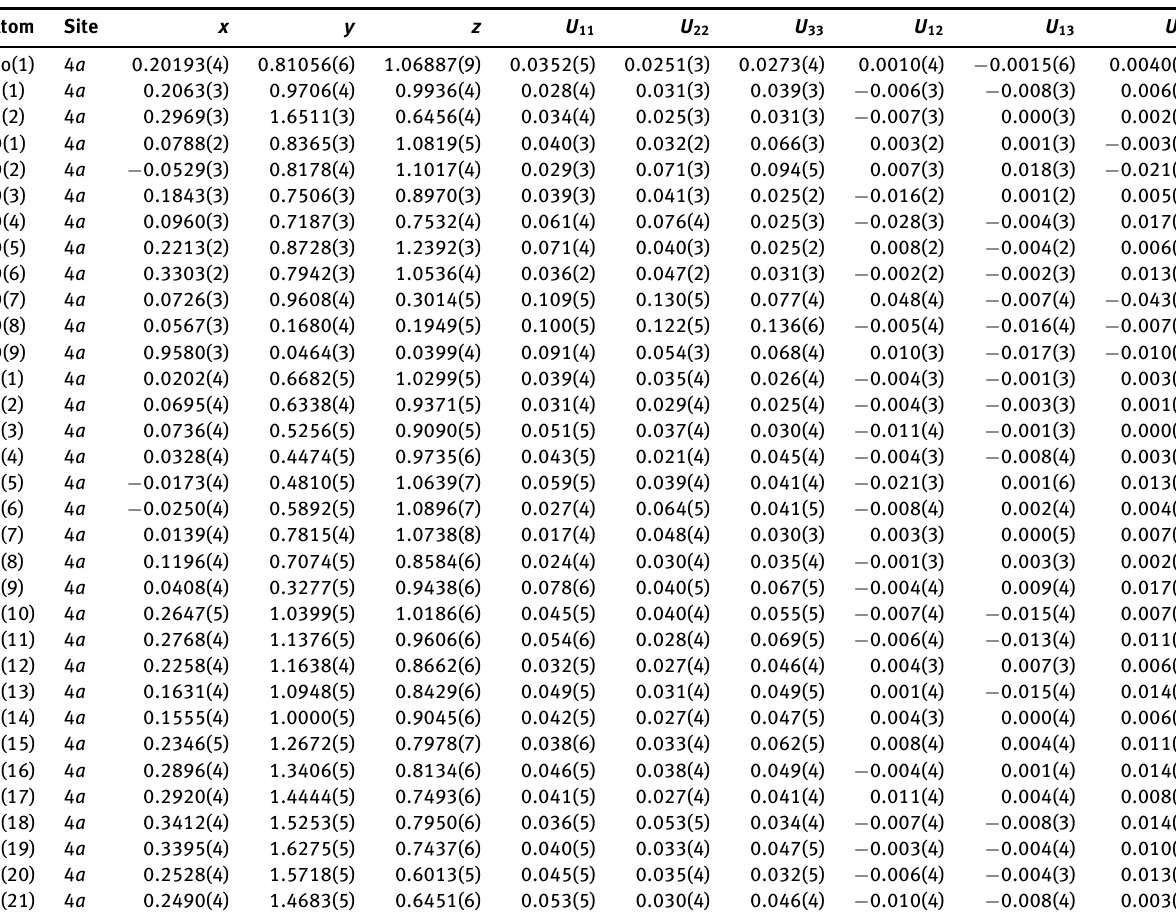
Table 3: Atomic displacement parameters (Å 2